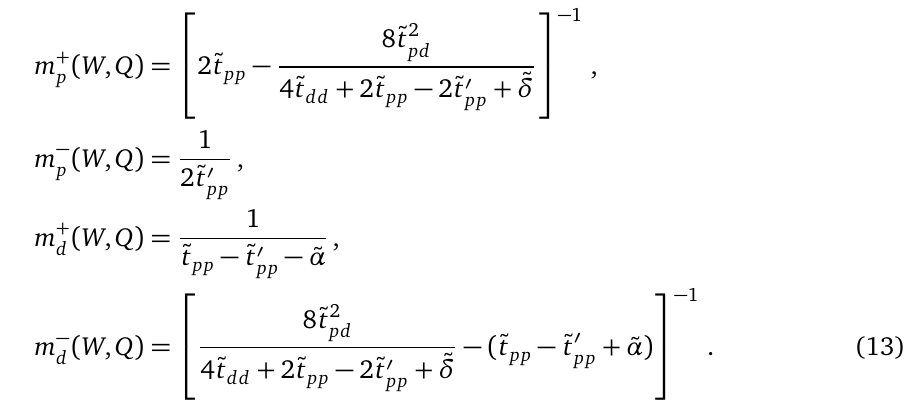
Figure 3: Phase Diagram : The perturbation theory predictions on diverging mass (solid lines) are plotted on top of the numerical calculation of the corresponding quantity that is a product of all effective masses at the QBT point ( puted from a L = 55 system size. The color scale yellow (blue) corresponds to large (cid:81) m ± (small) and the yellow region emerging from the origin matches very well p / d with the perturbation results. The light blue regions correspond to QBT phases where as the yellow regions identify each magic-angle condition with a flat dispersion in part (or all) of the QBT. The precise location of each magic-angle will weakly shift with increasing L but the yellow in the phase diagram is a good representative for the loca- tion of each magic-angle transition. The dark blue region (connected to W → ∞ ) is the QBT broken phase where gap opens at the nodal touching point. The two values of Q ’s we concentrate on the following discussion are also indicated as dashed